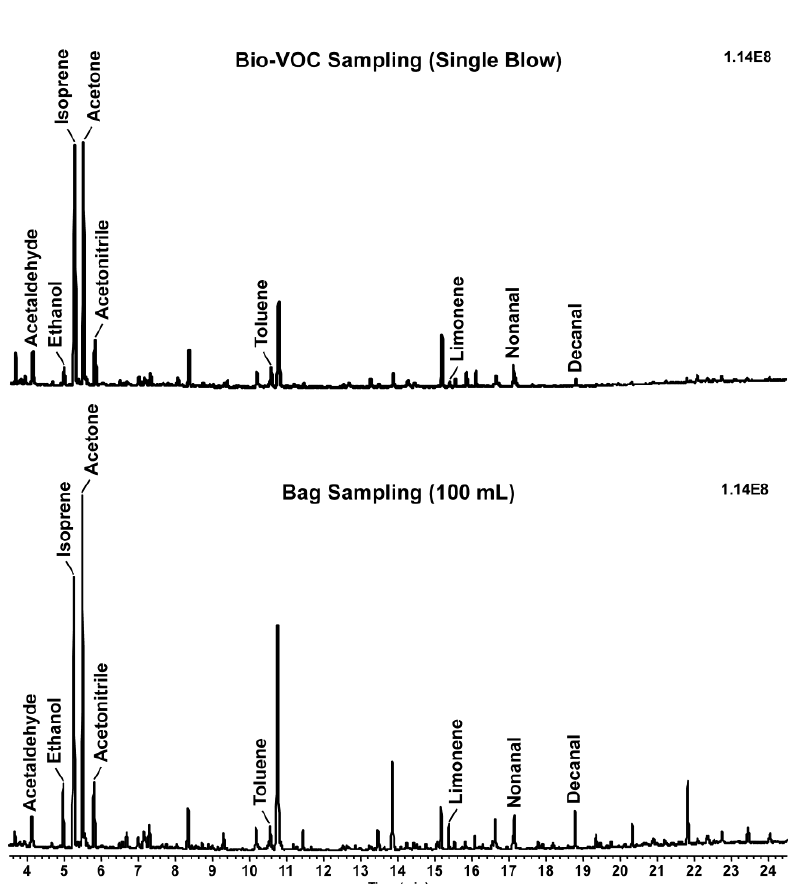
Figure 1. The total ion chromatograms (TICs) of volatile organic compounds (VOCs) detected in exhaled breath samples collected from a male smoker with different sampling methods. Prominent compound peaks include acetaldehyde (4.12 min), ethanol (4.97), isoprene (5.25), acetone (5.48), acetonitrile (5.80), toluene (10.56), limonene (15.53), nonanal (17.14) and decanal